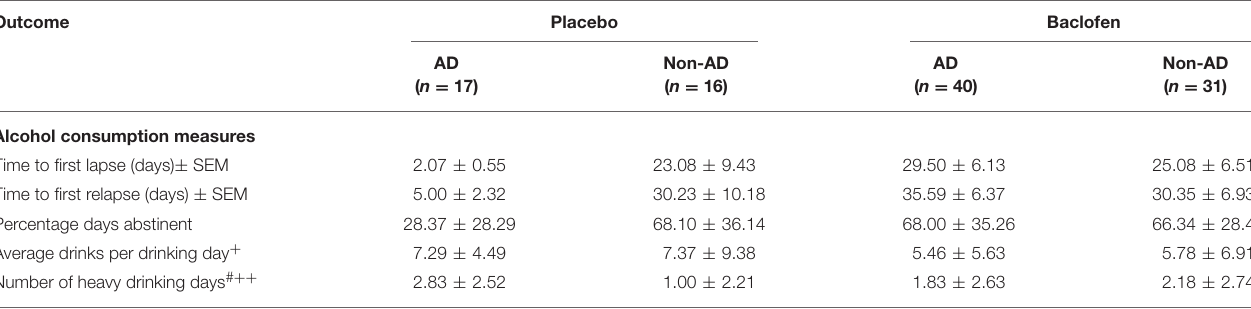
TABLE 3 | Intention to treat: drinking outcome measures at week 12 of participants treated with either baclofen (30–75mg) or placebo according to concurrent antidepressant use. Outcome Placebo